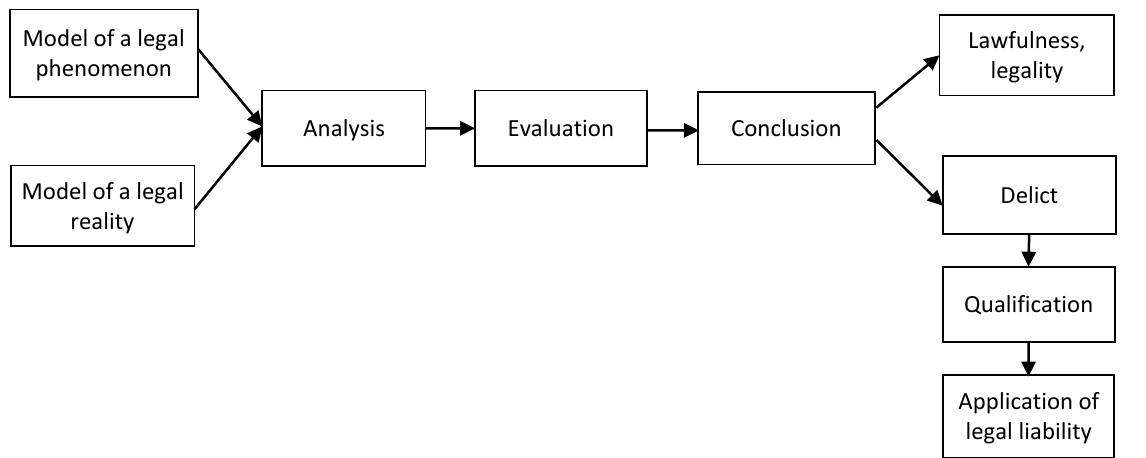
Figure 1. Model of the legal